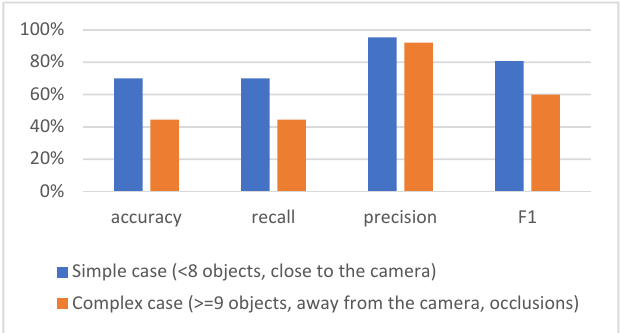
Figure 12. Results of player detection with Yolo in simple and complex scenarios.